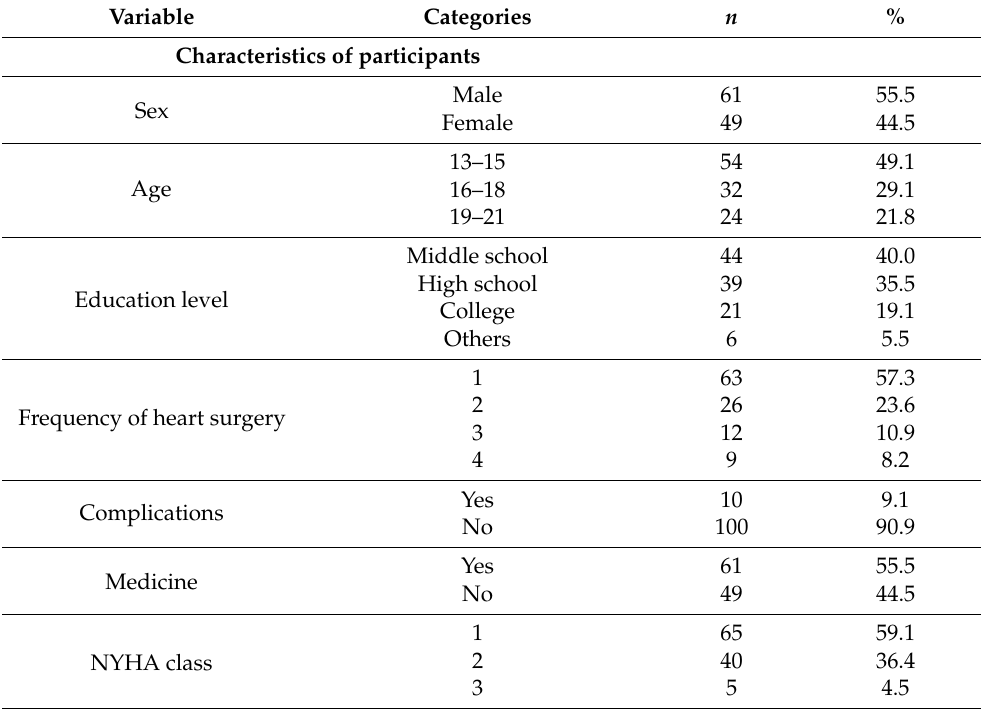
Table 1. Demographic characteristics of